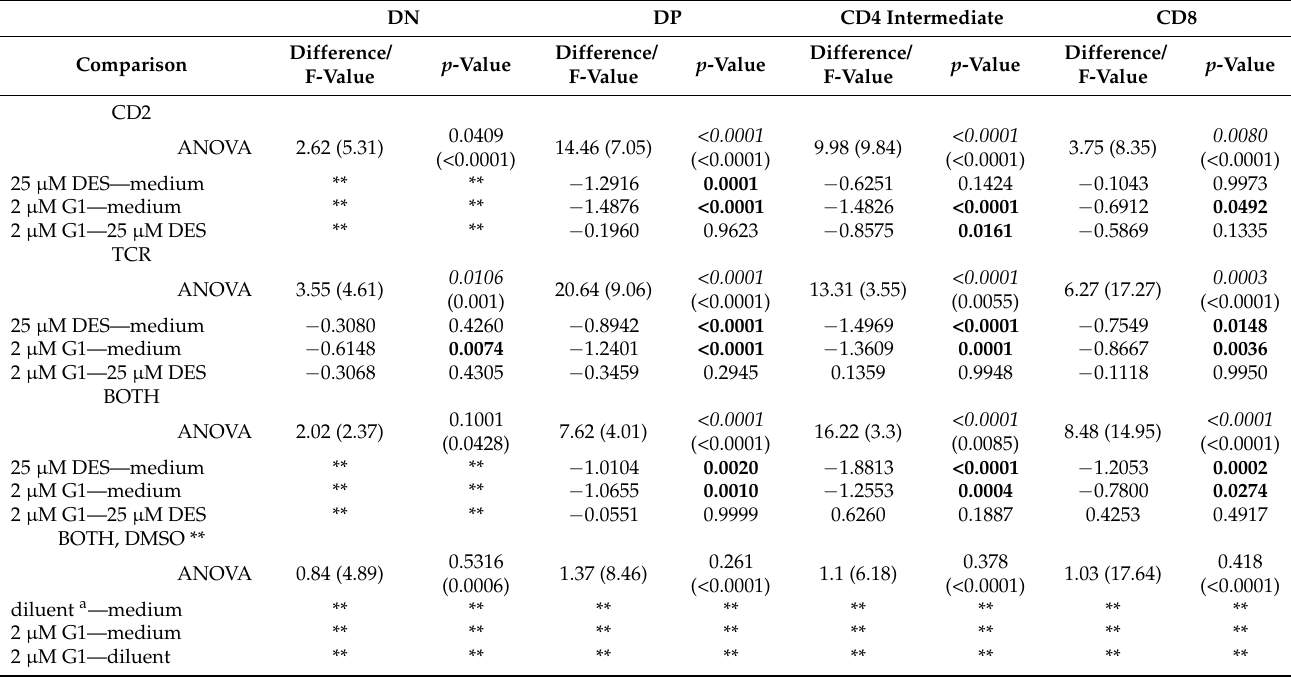
Table 2. Pairwise comparisons of thymocyte subpopulations from Tukey HSD post hoc